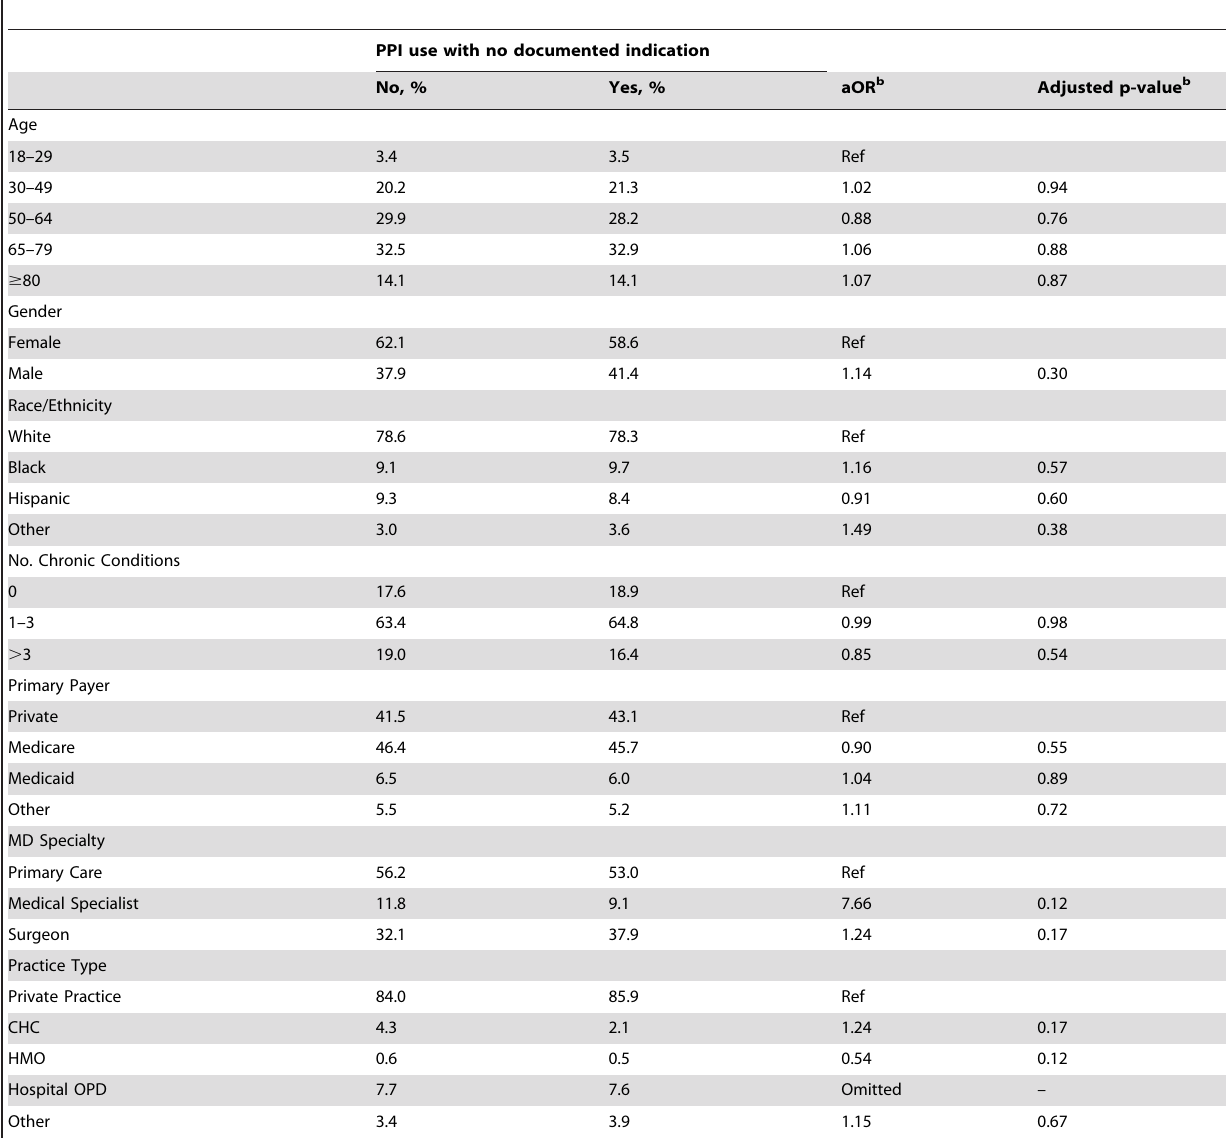
Table 4. Association between patient and physician characteristics and use of PPIs in patients with no documented indication, 2009 a,b